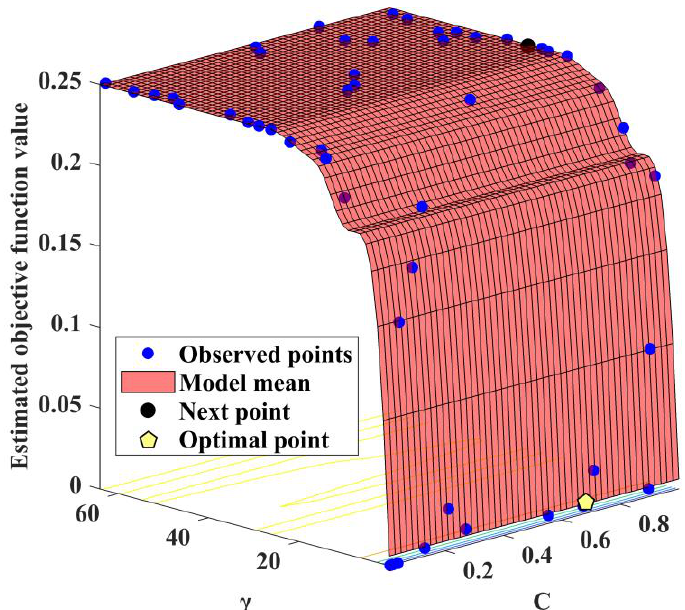
Figure 10. Bayesian optimization process.